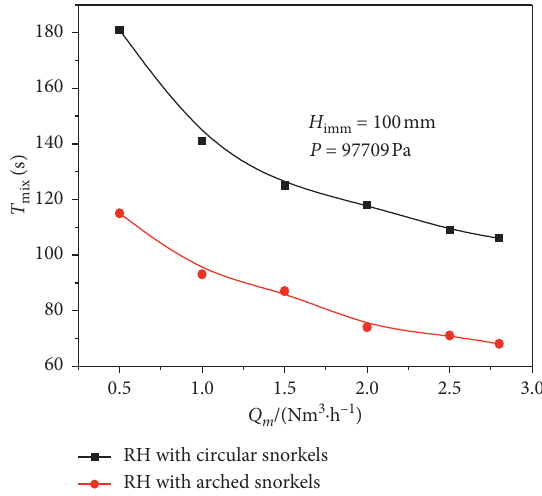
Figure 8: Relationship between Q m and T mix in RH with arched snorkels and RH with circular